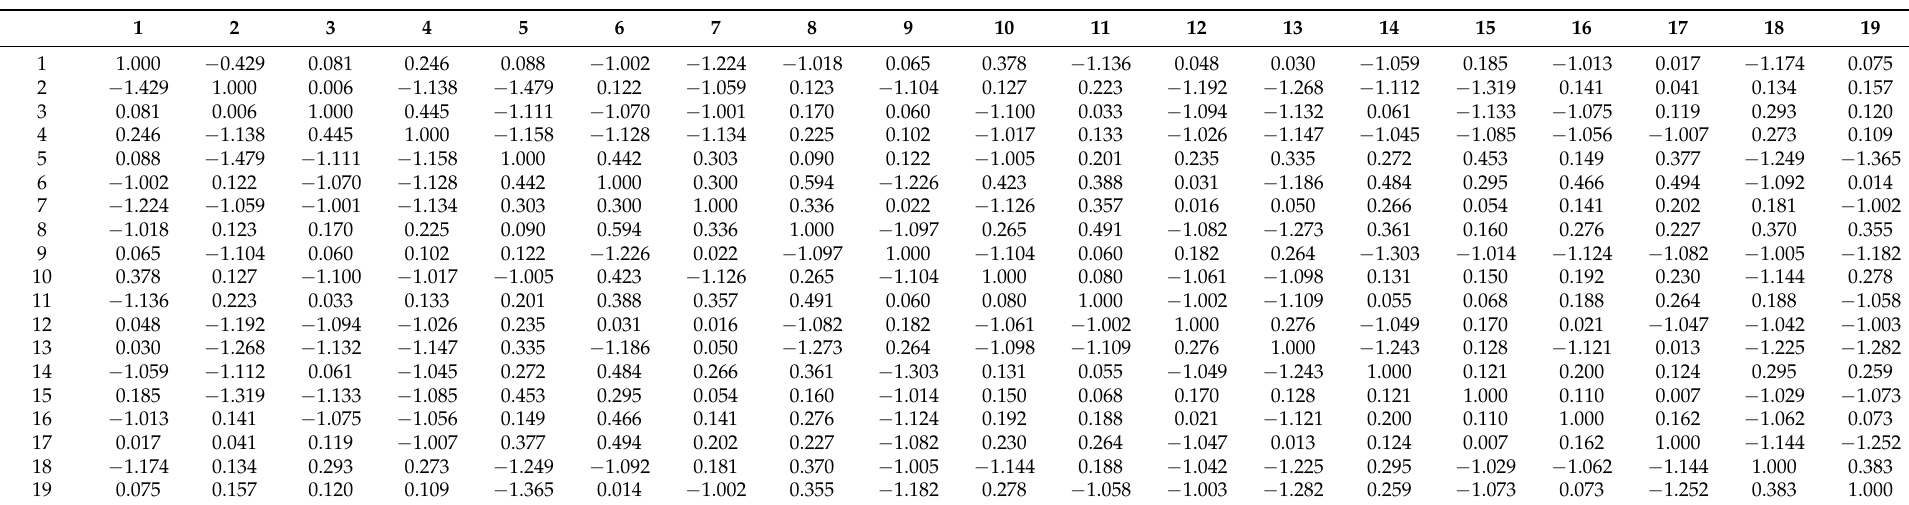
Table 5. The correlation coefficients of the major RON